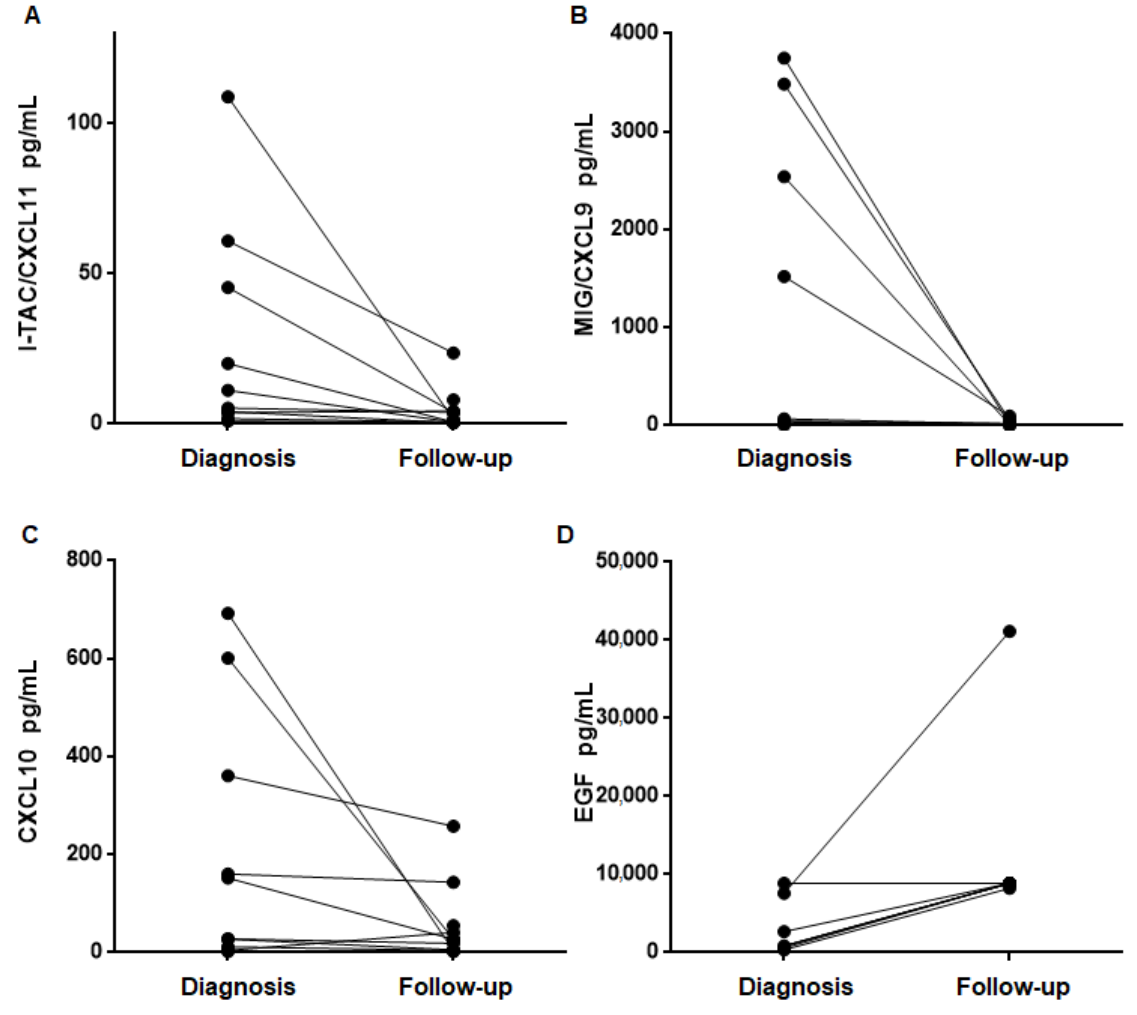
Figure 4. The urinary concentration of CXCL 11 ( A ), CXCL9 ( B ), CXCL10 ( C ) and EGF ( D ) at the moment of the diagnosis of acute tubulointerstitial nephritis and in the follow-up after treatment.